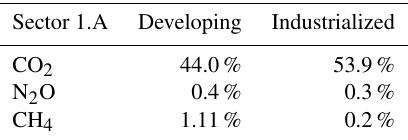
Table 4. Share of GHG emissions (derived from CO 2 , CH 4 , and N 2 O expressed in CO 2eq . ) of developing and industrialized coun- tries for sector 1.A based on EDGAR emissions for the year